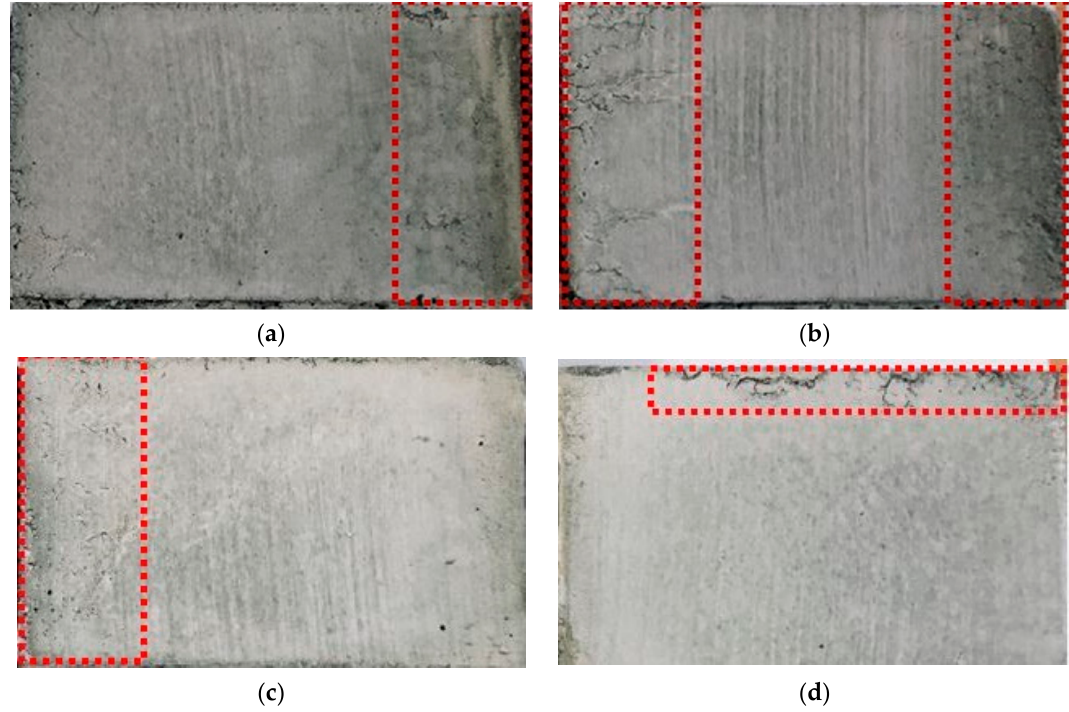
Figure 8. Fractured interface between the aggregate and the QM after the IFT test (effects of the aggregate water saturation content); ( a ) F-0-50, ( b ) F-0-100, ( c ) F-15-50, ( d ) F-15-100.